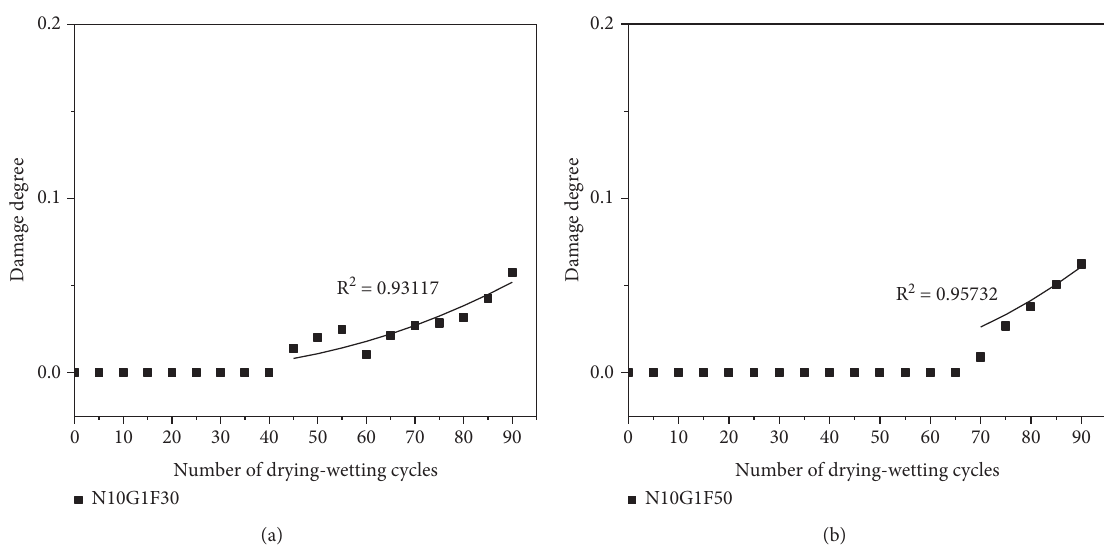
Figure 10: Variation of the damage degree of concrete with different contents of fly ash. (a) N10G1F30. (b)